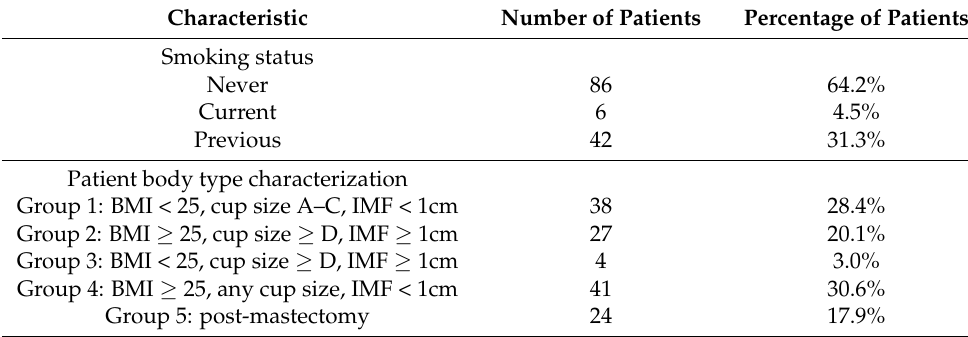
Table 1. Baseline patient and treatment characteristics (134 patients